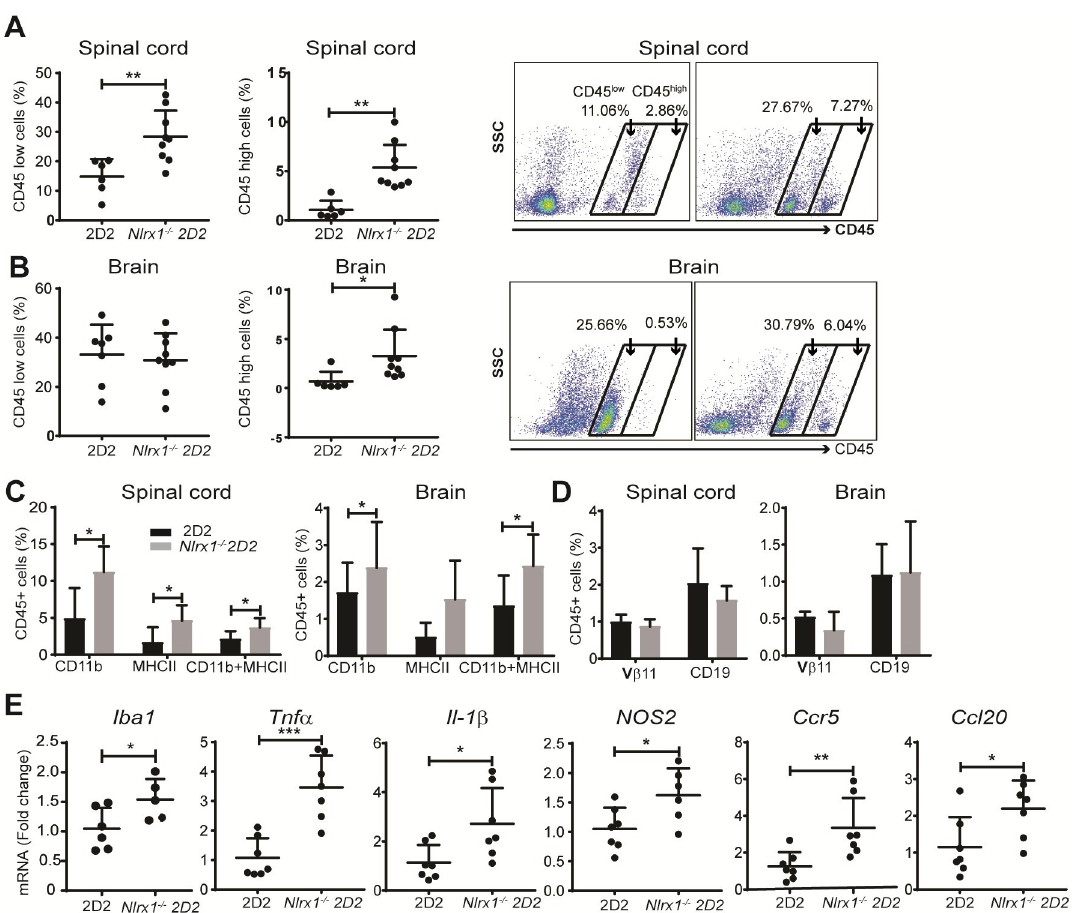
Fig 4. Preclinical stages of inflammation in the CNS of Nlrx1 −/− 2D2 mice. (A) The percentages of CD45 low microglia and CD45 high myeloid cells in the spinal cords and brains of Nlrx1 −/− 2D2 mice compared with 2D2 mice, quantified by flow cytometry, Mann– Whitney U test. ( B) Representative plots showing CD45 low and CD45 high gates in spinal cord and brain samples from Nlrx1 −/− 2D2 and 2D2 mice, Mann–Whitney U test. (C) The percentage of activated myeloid cells (CD11b + MHCII + ) in the spinal cord and brain of Nlrx1 −/− 2D2 and 2D2 mice ( n = 8 mice per group). (D) The percentage of V β 11 + T cells and CD19 + B cells in the spinal cords and brains of Nlrx1 −/− 2D2 and 2D2 mice, quantified by flow cytometry ( n = 6 mice per group). (E) The mRNA levels of Iba1 and inflammatory mediators in Nlrx1 −/− 2D2 brains compared with 2D2 brains, quantified by qPCR ( n = 7 mice per group). All the data are presented as mean ± SD. � P � 0.05, �� P � 0.01, ��� P � 0.001 as determined by the Student t test, except when Mann-Whitney U test was specified. Underlying data can be found in S1 Data. CNS, central nervous system; Iba1, ionized calcium binding adaptor molecule 1; MHC, major histocompatibility complex; Nlrx1 , nucleotide-binding, leucine-rich repeat containing X1; qPCR, quantitative polymerase chain